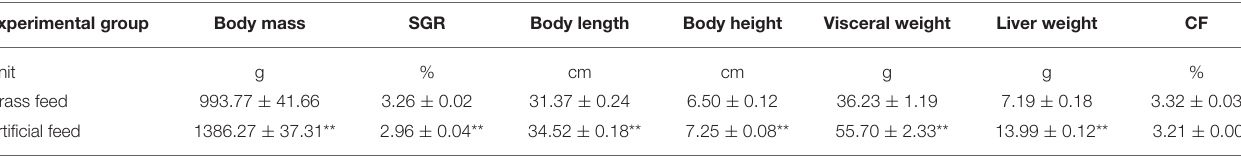
TABLE 2 | Growth performance of C. idellus fed with different feeds. Experimental